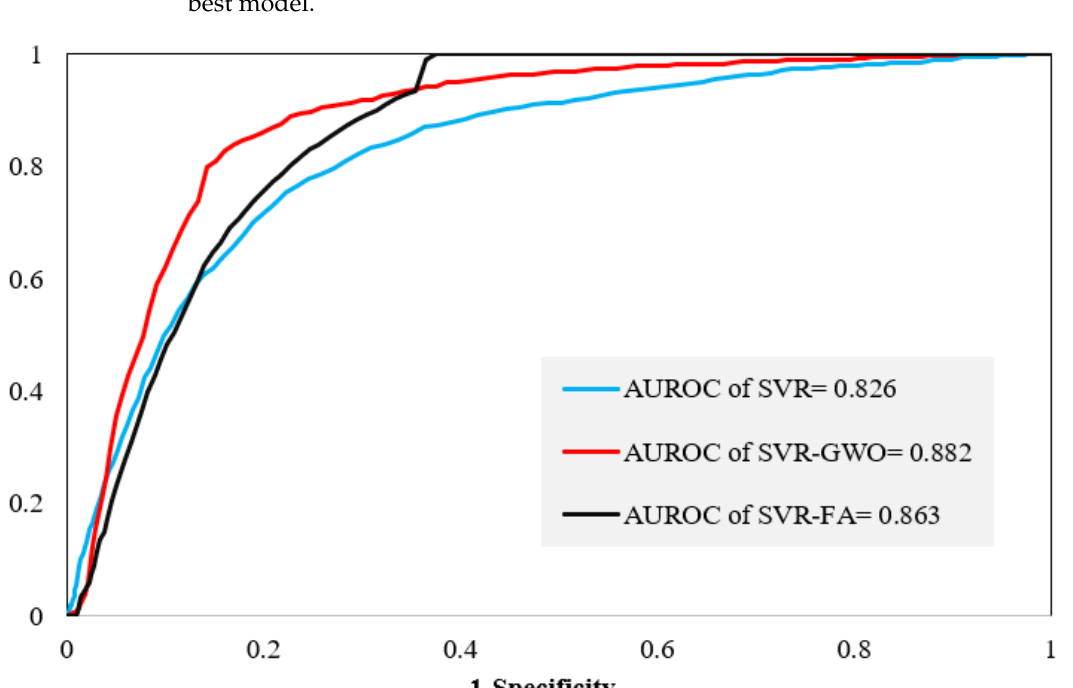
Figure 11. AUROC curves of hybrid models using the validation dataset.